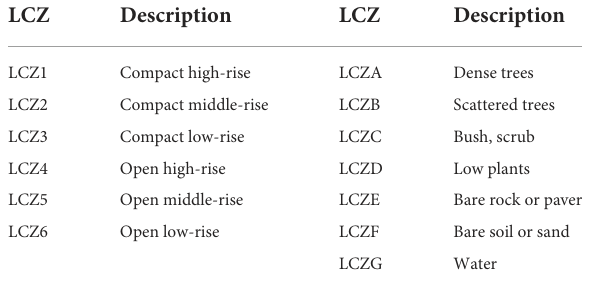
TABLE 2 Classification criteria of